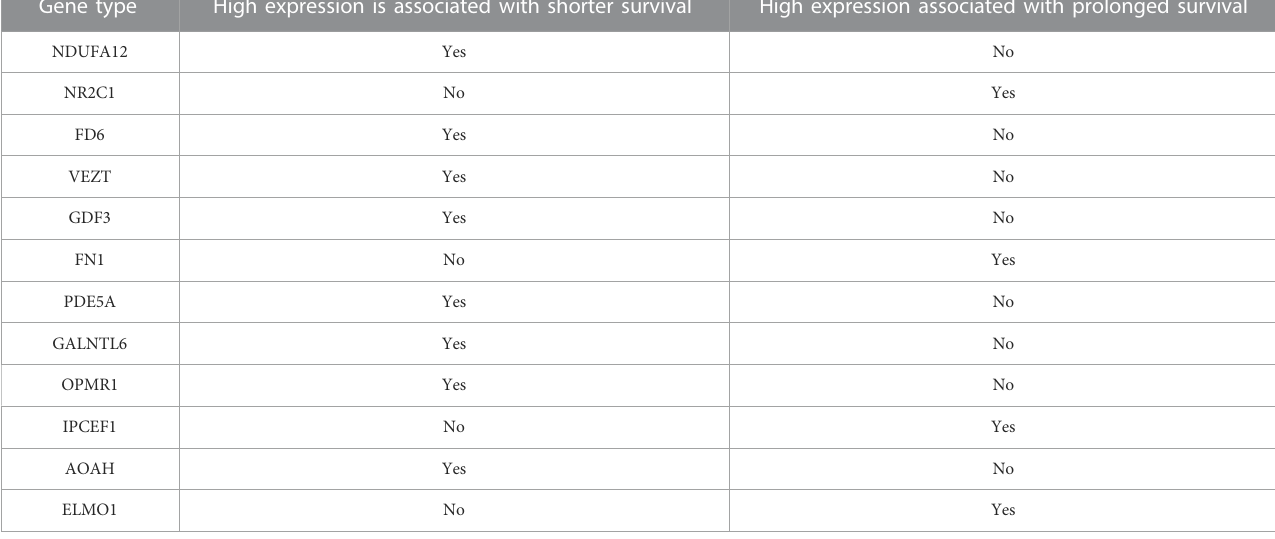
TABLE 3 Prognostic value of thyroid cancer genes. Gene